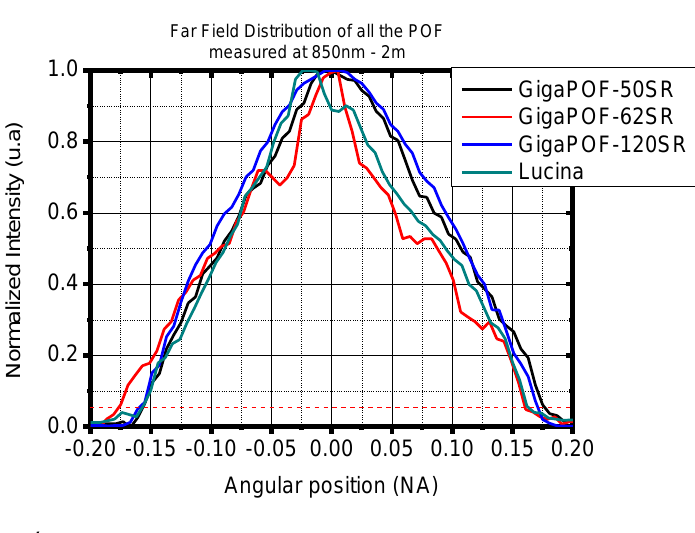
Figure 7. Far field measurement of the PFGI-POF.